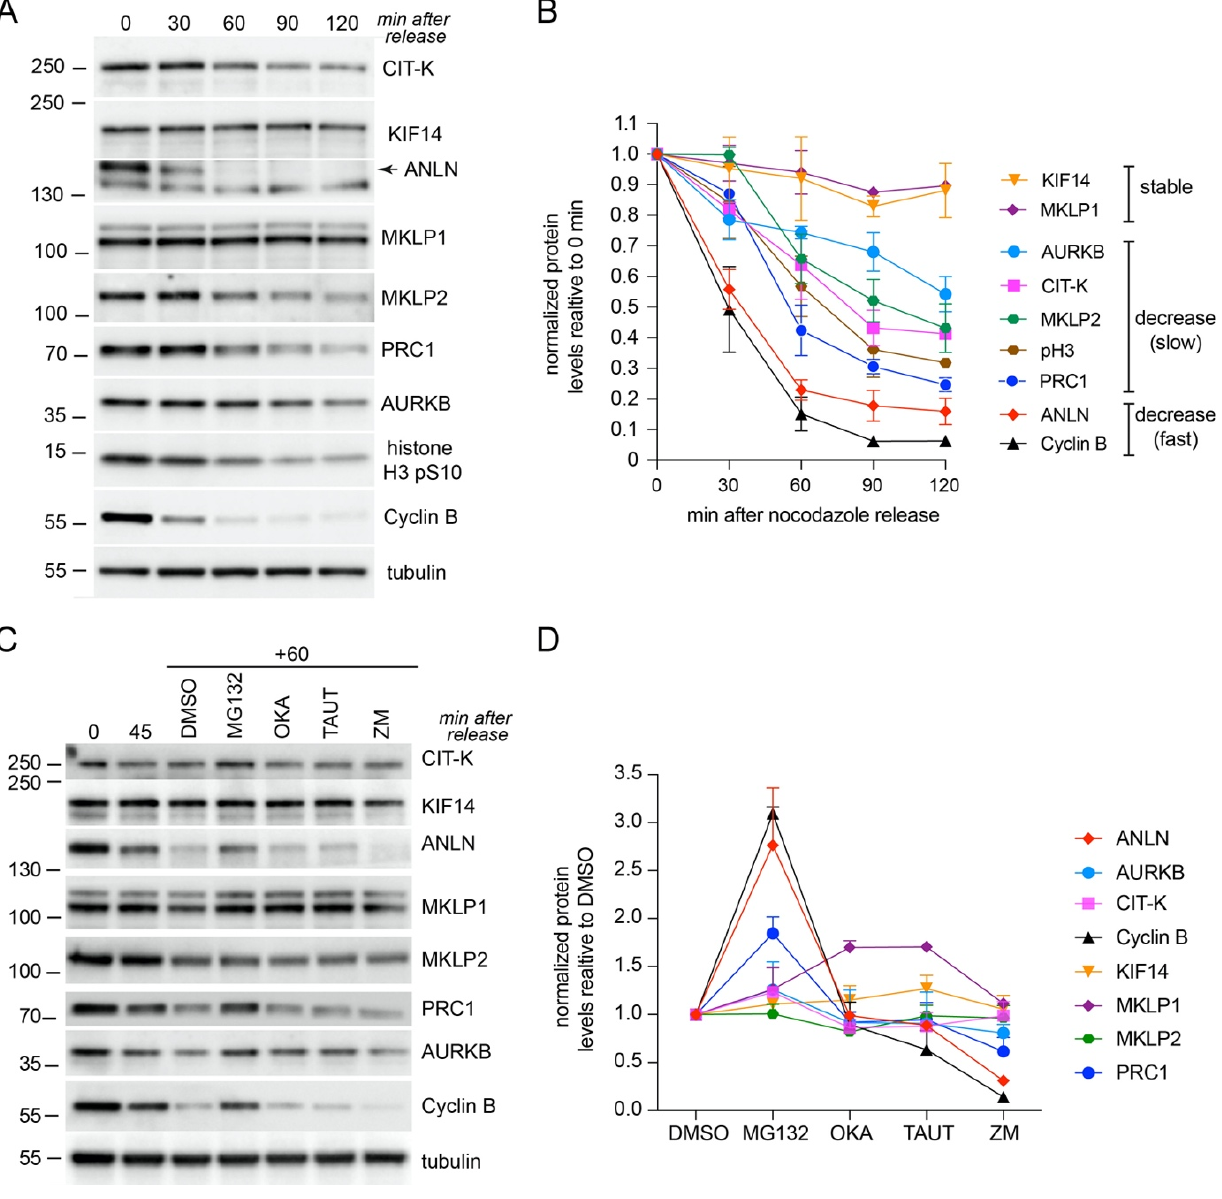
Figure 2. Different expression profiles of midbody proteins during mitotic exit. ( A ) Time course analysis of midbody protein expression during mitotic exit. HeLa cells were synchronized by thymidine/nocodazole block and then collected at the indicate time points after nocodazole release. Proteins were extracted and used in Western blot analysis to identify the antigens indicated to the right. The numbers on the left indicate the sizes of the molecular mass marker. ( B ) Graph showing the quantification of protein levels, normalized to tubulin and relative to levels at time 0 min, from at least two different Western blots like the one shown in ( A ) using protein extracts from two separate experiments. ( C ) Effect of different inhibitors on midbody protein levels. HeLa cells were syn- chronized by thymidine/nocodazole block, released for 45 min in fresh medium, and then incubated for further 60 min in MG132, okadaic acid (OKA), tautomycetin (TAUT), ZM447439 (ZM), or the solvent DMSO as control. Proteins were extracted and used in Western blot analysis to identify the antigens indicated to the right. The numbers on the left indicate the sizes of the molecular mass marker. ( D ) Graph showing the quantification of protein levels, normalized to tubulin and relative to DMSO levels, from at least two different Western blots like the one shown in ( C ) using protein extracts from two separate experiments.